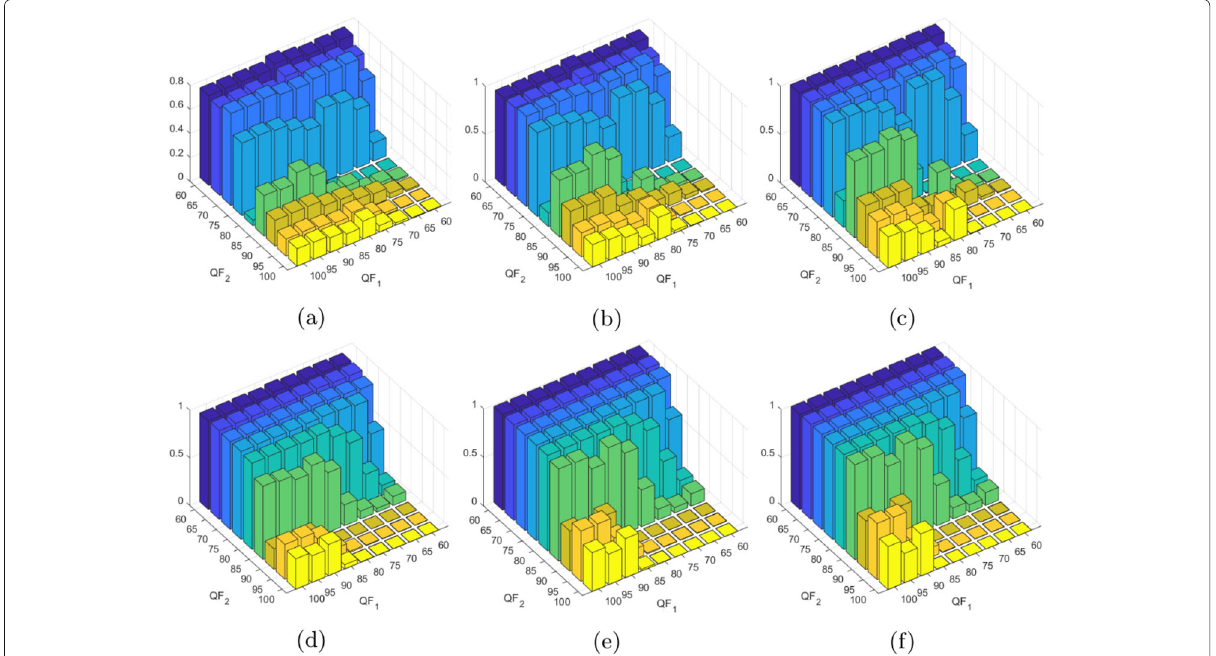
Fig. 7 Overall accuracy of the proposed method on JPEG triple compressed images when trying to estimate the Q m − 1 quantization factors. First row identifies patch size 64 × 64, 128 × 128, 256 × 256 and QF 3 = 80 respectively [(a),(b),(c)], while second row is related to the same patch sizes and QF 3 = 90 [(d),(e),(f)